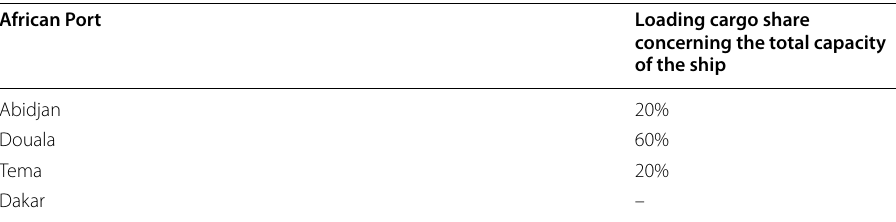
Table 3 Loading cargo share in African